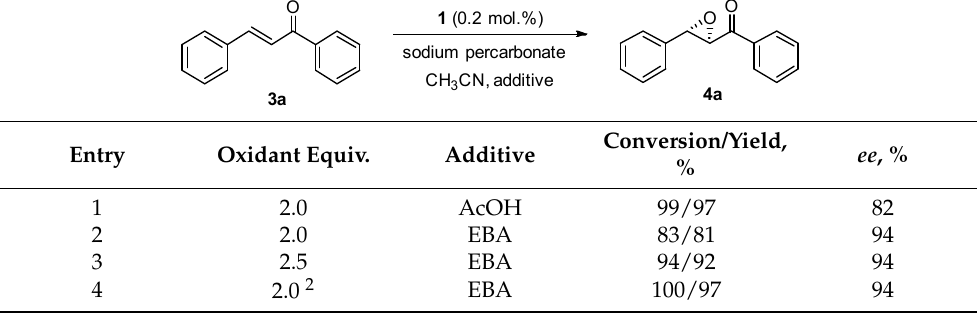
Table 1. Asymmetric epoxidation of chalcone with sodium percarbonate in the presence of catalyst 1 1 . 1 (0.2